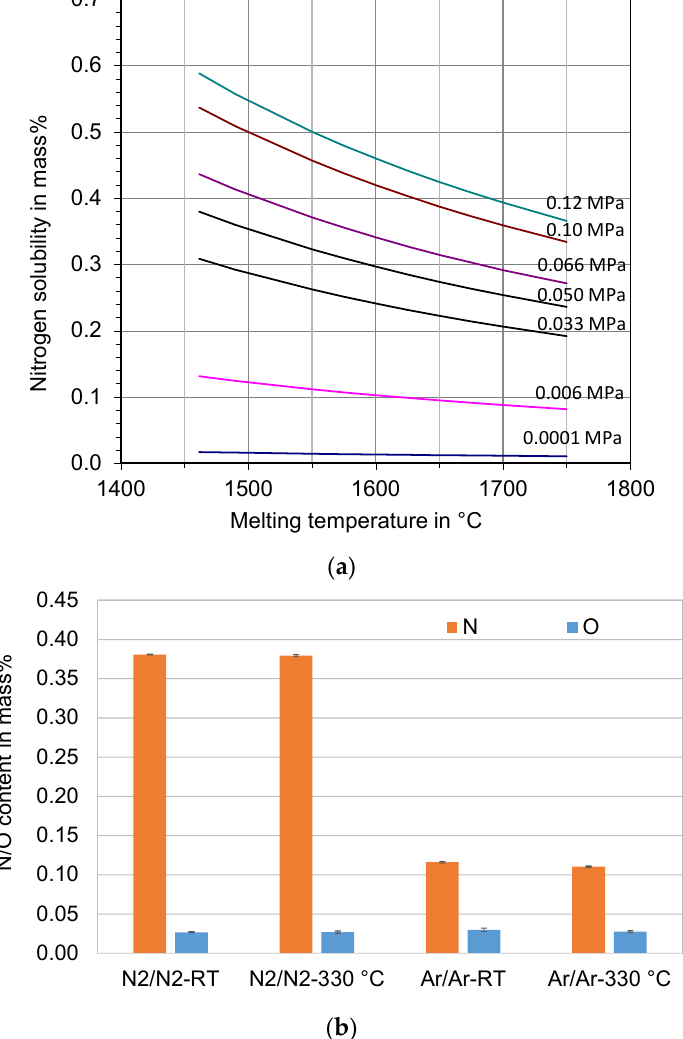
Figure 1. ( a ) Calculated nitrogen solubility in the melt of the super duplex stainless steel X2CrNiMoCuWN25-7-4 at different melt temperatures and nitrogen partial pressures, and ( b ) measured nitrogen and oxygen content of the atomized powders.